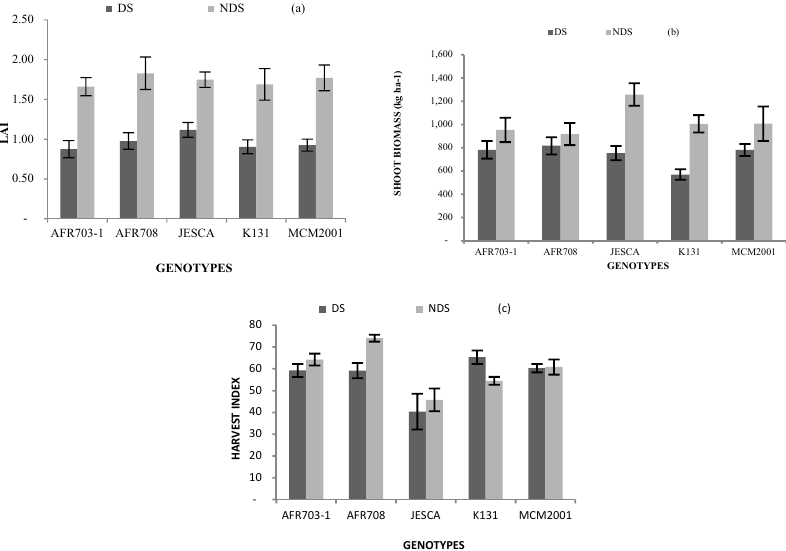
Figure 1. Interaction between genotypes and drought conditions on ( a ) LAI; ( b ) shoot biomass and ( c ) Harvest index. (Bars over the mean indicate standard error). LAI: Leaf area index, DS: Drought stress and NDS: Non-drought stress.